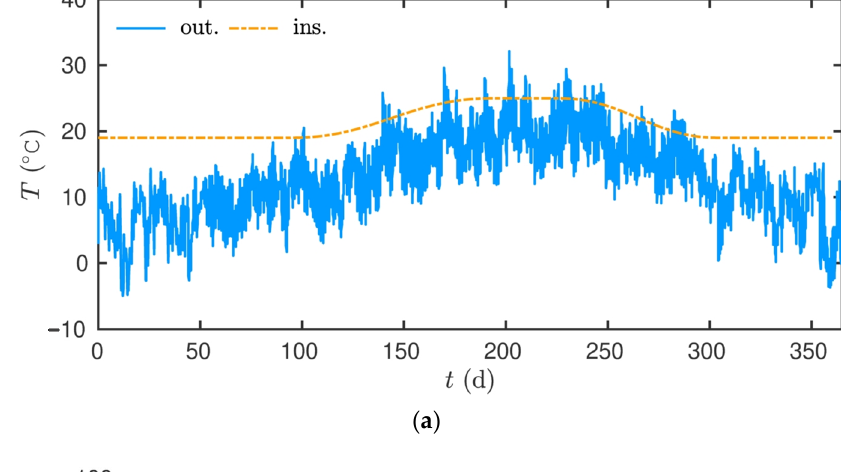
14 of 19 Figure 15. Non-isothermal case: Evolution of the relative humidity of aged and reference hemp concrete (W: Weathered; R: Reference).